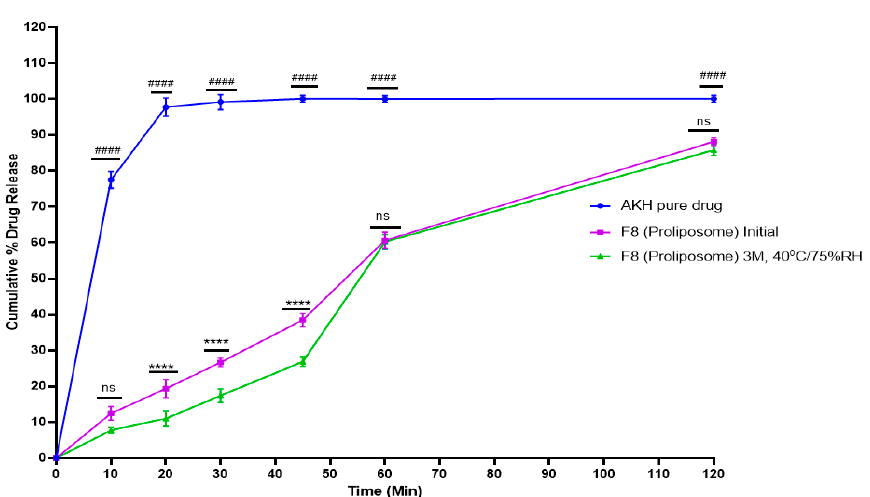
Figure 8. In vitro release profile of AKH pure drug and proliposomal formulation of initial and 3 M stability samples in 0.01 N HCl ( n = 3). Time (min) vs. Cumulative % drug release; ####—AKH pure drug vs. F8 (Proliposome) Initial with significance p < 0.0001; ****—F8 (Proliposome) Initial vs. F8 (Proliposome) 3 M, 40 °C/75% RH with significance p < 0.0001; ns—F8 (Proliposome) Initial vs. F8 (Proliposome) 3 M, 40 °C/75% RH is non-significant.